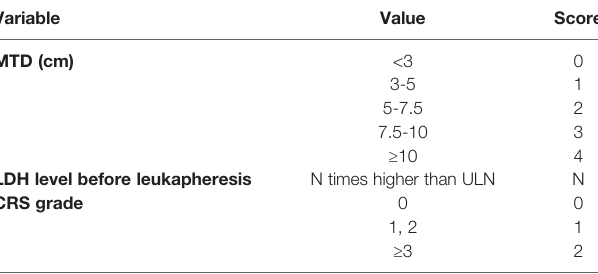
TABLE 3 | Scores of factors that are signi fi cant in the univariate analysis.